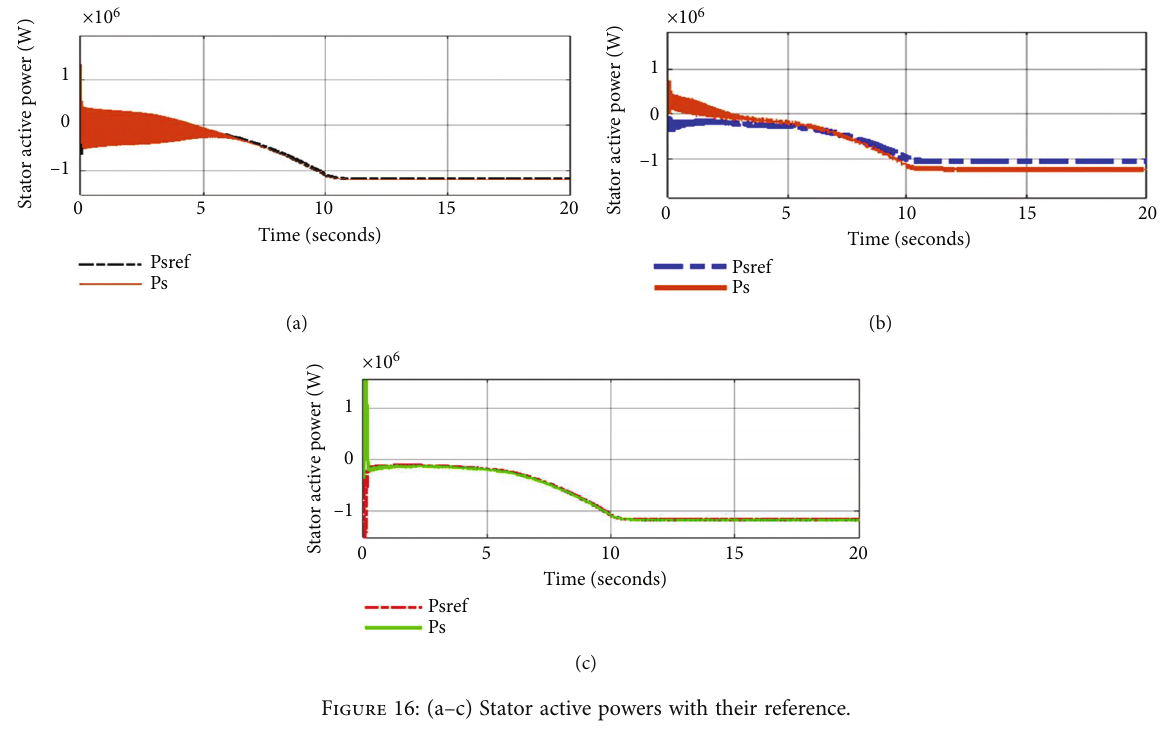
Figure 16: (a – c) Stator active powers with their reference.